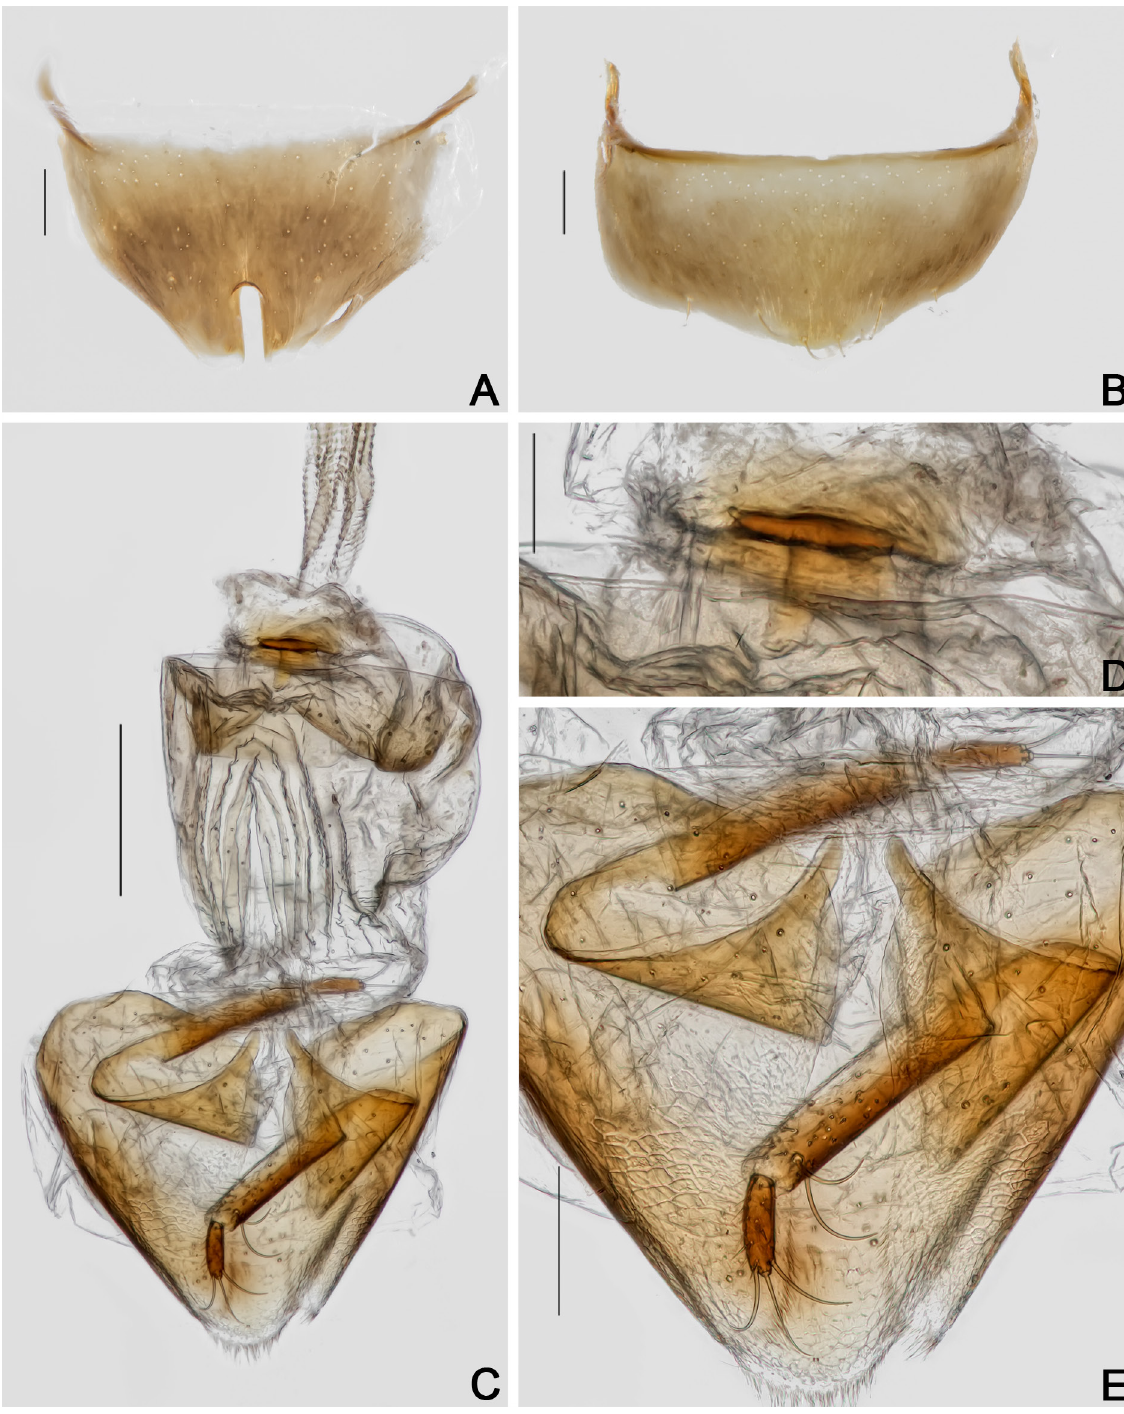
Fig. 21. Cyparium lescheni sp. nov., paratype, ♀ (CELC). A . Tergite VIII. B . Sternite VIII. C . Terminalia. D . Sclerite of vaginal plate. E . Ovipositor. Specimen collected at Mata da Biologia, Viçosa (MG, Brazil). Scale bars: A–B, E = 0.1 mm; C = 0.2 mm; D = 0.05